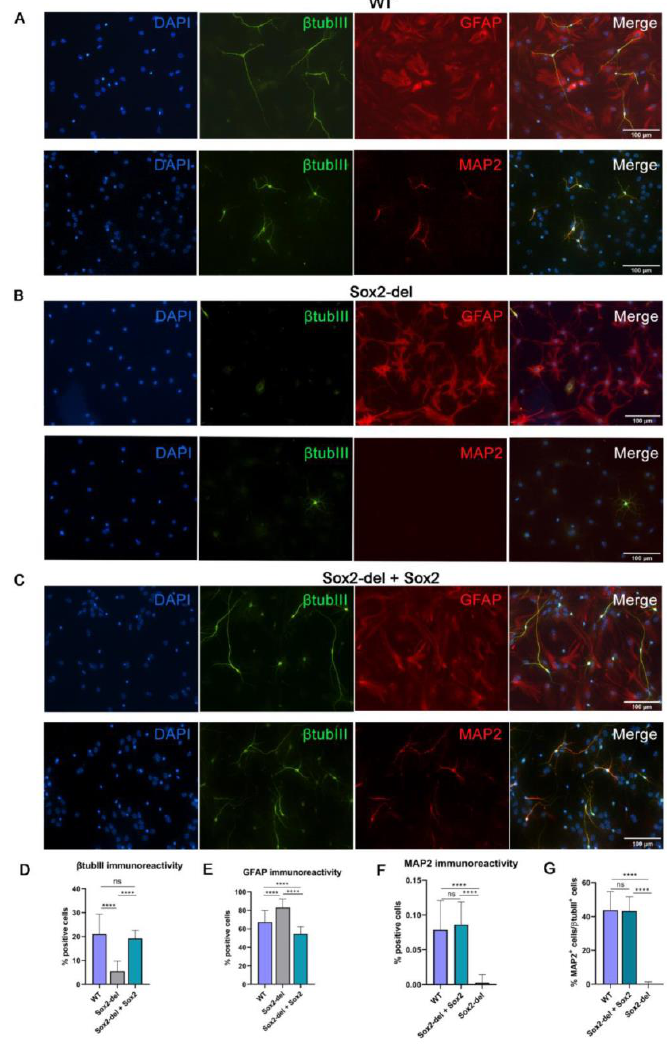
Figure 1. Sox2 deletion impairs neuronal differentiation of NSC, and this is rescued by lentiviral Sox2 re-expression. ( A ) Immunofluorescence (IF) for β -tubulinIII, a neuronal marker, GFAP, a glial marker, and MAP2, a marker of mature neurons in WT cells at D11. Top: β -tubulinIII positive cells show long arborizations and mature neuronal morphology. Bottom: all β -tubulinIII positive cells are also MAP2 positive. ( B ) IF for β -tubulinIII, GFAP and MAP2 IF in Sox2-del cells at D11. IF shows few β -tubulinIII positive cells with an immature morphology; some cells also show β -tubulinIII/GFAP double positivity. MAP2-positive cells are absent. ( C ) β -tubulinIII, GFAP, and MAP2 IF in Sox2 - transduced Sox2-del cells (Sox2-del + Sox2) at D11. ( D – F ) Histograms show the percentage of cells positive for β -tubulinIII, GFAP and MAP2, respectively, compared to the total cell number. ( G ) Histograms show the percentage of MAP2-positive cells/ β -tubIII-positive cells. ( D , E ) Results are the mean of counting 16–20 fields in each of n = 7 independent differentiation experiments conducted on 3 different WT samples (from 3 WT mice) and 3 different Sox2-del samples (from 3 Sox2-del mice); ( F , G ) Results are the mean of 16–19 fields counted in n = 2 independent differentiation experiments, each conducted on two WT and two Sox2-del samples. Statistical significance was assessed by Brown Forsythe ANOVA and Dunnet T3 test (**** p < 0.0001; ns: not